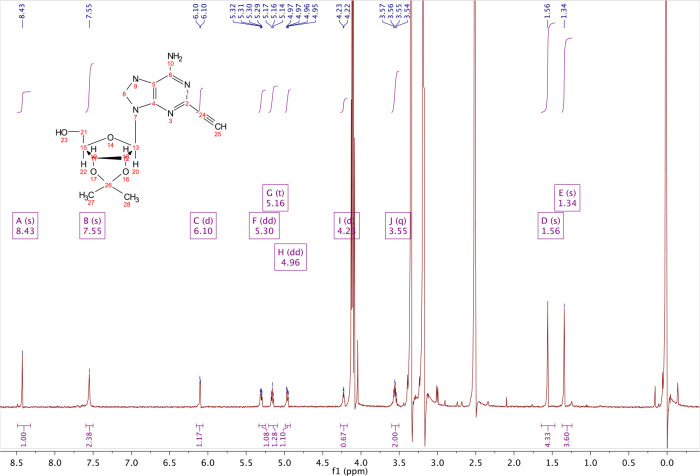
1H NMR of compound 3.